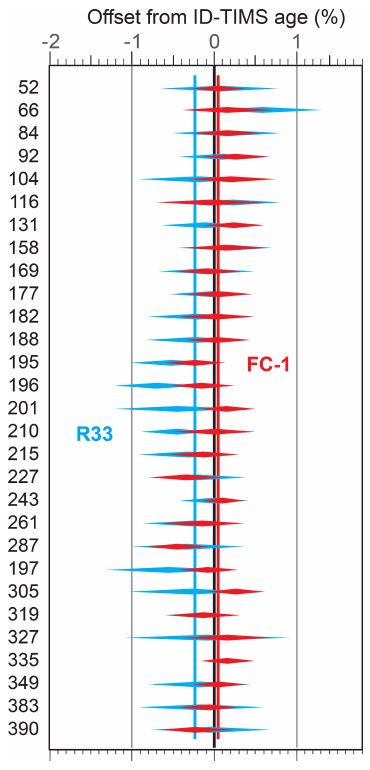
Figure 4. Plot showing the accuracy of 206 Pb ∗ / 238 U dates of sec- ondary standards analyzed during the current study. Each pair of symbols represents the weighted mean age and 2 σ uncertainty of R33 and FC-1 analyses conducted with each sample, expressed as % offset from reported ID-TIMS dates of 1099.9Ma for FC-1 (Paces and Miller, 1993) and 419.26Ma for R33 (Black et al., 2004). For FC-1, 1065 analyses are reported, with MSWD of 0.95 for all anal- yses. For R33, 295 analyses are reported, with MSWD of 0.92 for all analyses. Data are reported in Table